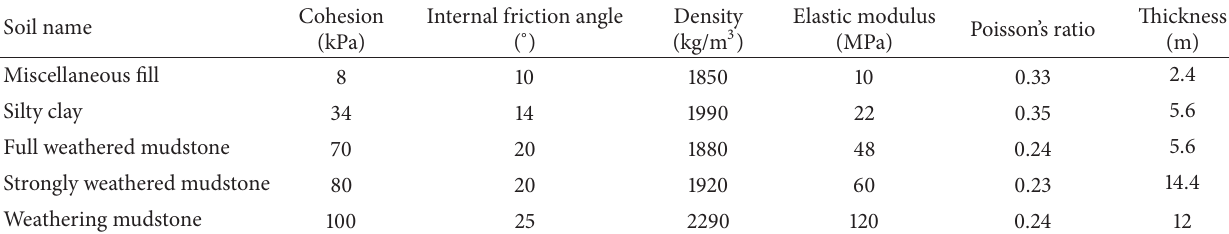
Table 1: Physical and mechanical parameters of computational model.